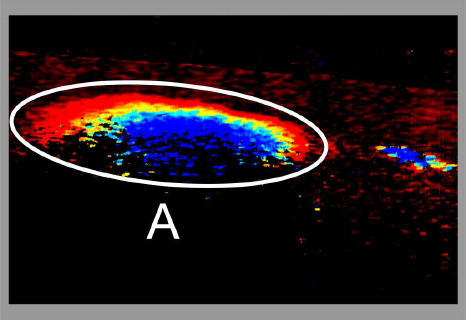
Fig. 1. Doppler OCT image of the sagittal vein in a